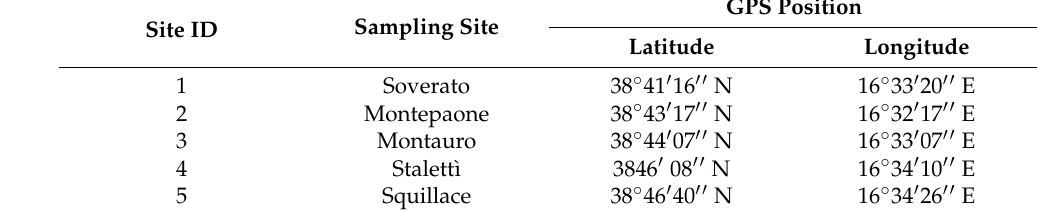
Table 1. The sampling sites, together with their IDs and GPS coordinates.